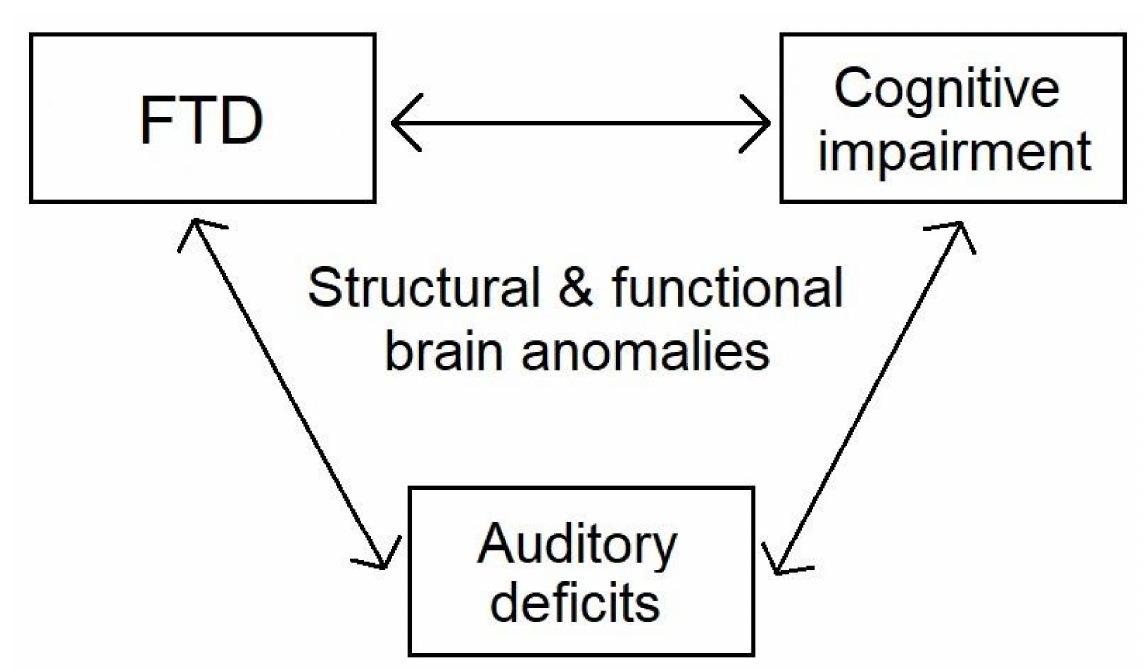
Figure 2. Interrelations of FTD, cognitive impairment, and auditory deficits in